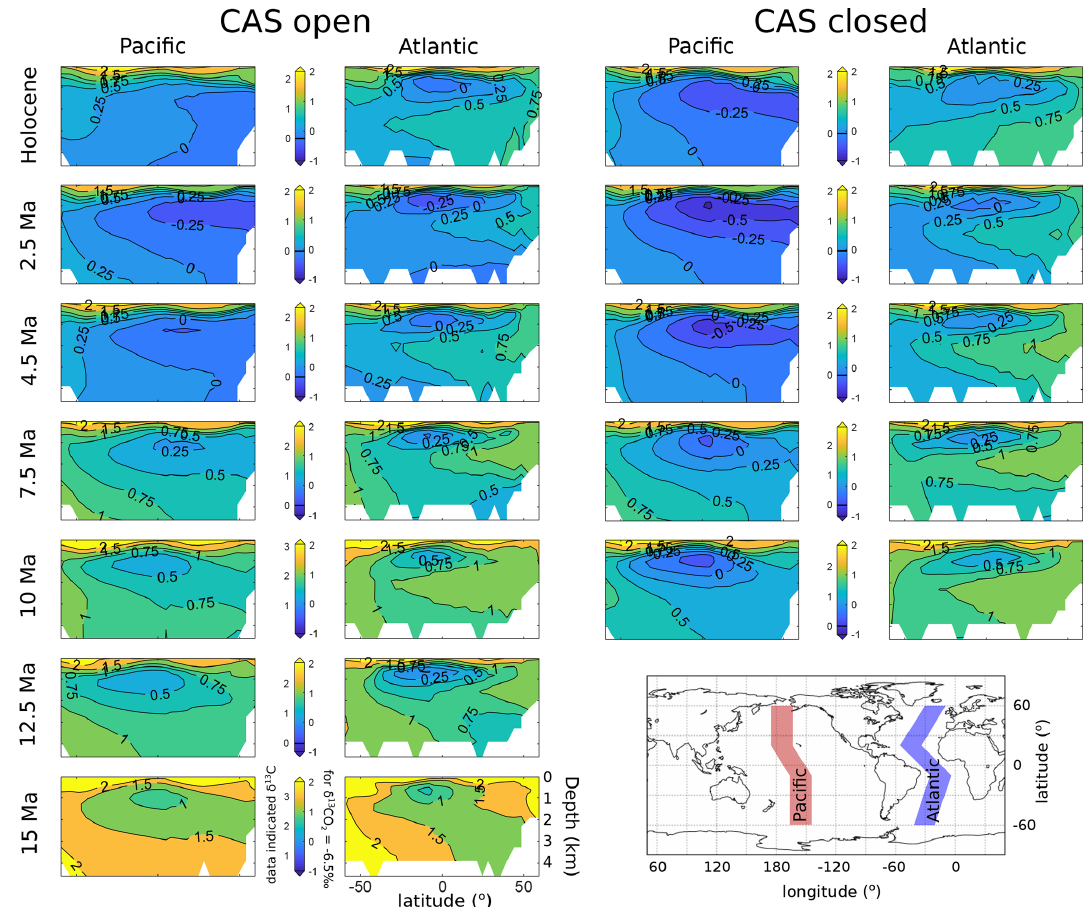
Figure 12. Pacific and Atlantic ocean cross sections of δ 13 C, where the shading and contour labelling are with respect to an atmospheric δ 13 CO 2 forcing of − 6 . 5‰. This shading allows the comparison of the inner-ocean δ 13 C between the time slices, for example, 15Ma shows values further from the atmospheric value than the Holocene. The data-indicated δ 13 C value is shown on the left of each colour bar. The inset map shows the transect locations used to make the cross